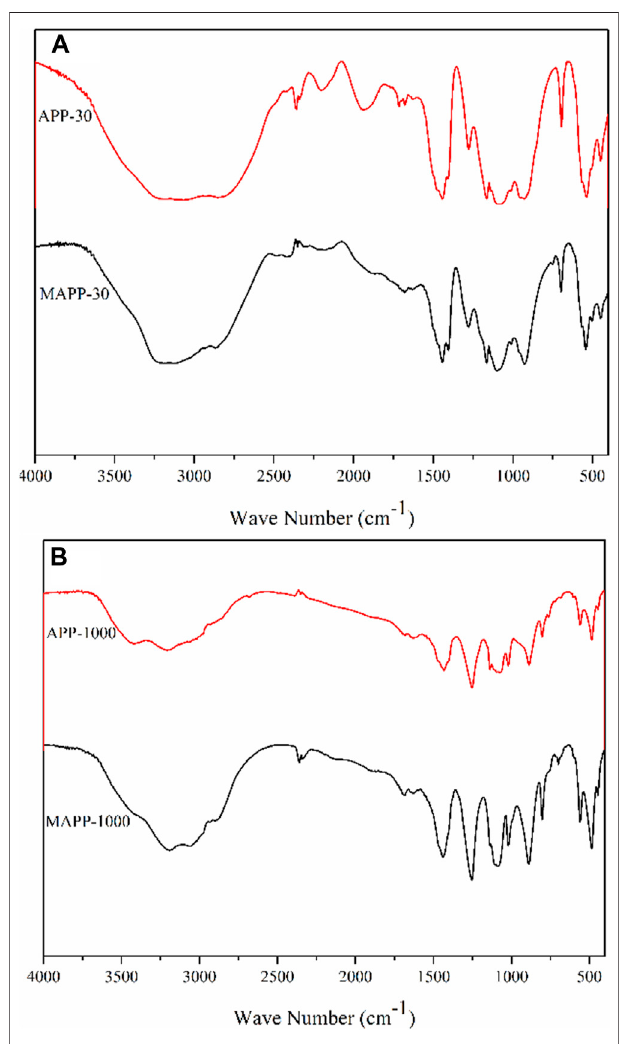
FIGURE 3 | FTIR spectra of APP-30, MAPP-30 (A) and APP-1000, MAPP-1000 (B) .